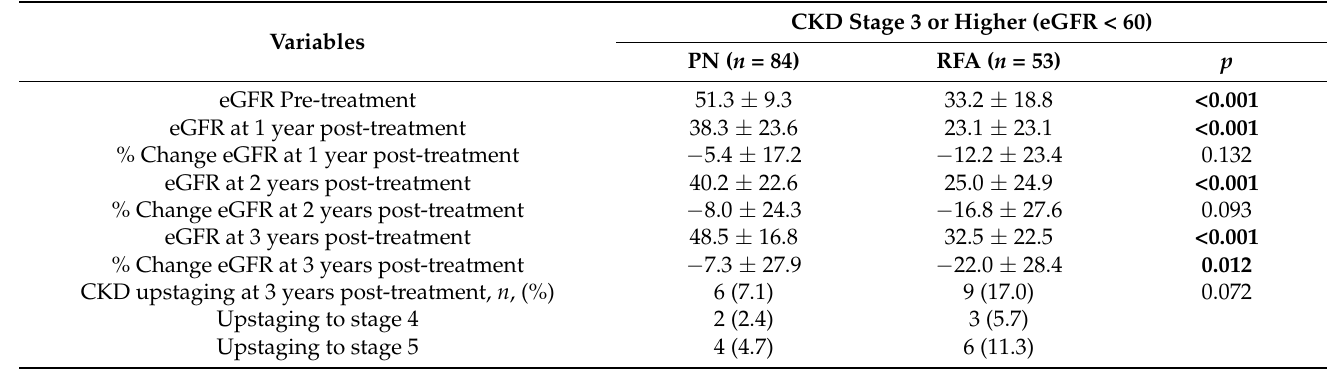
Table 4. Pre- and post-treatment estimated renal function according to treatment method in patients with CKD stage 3 or